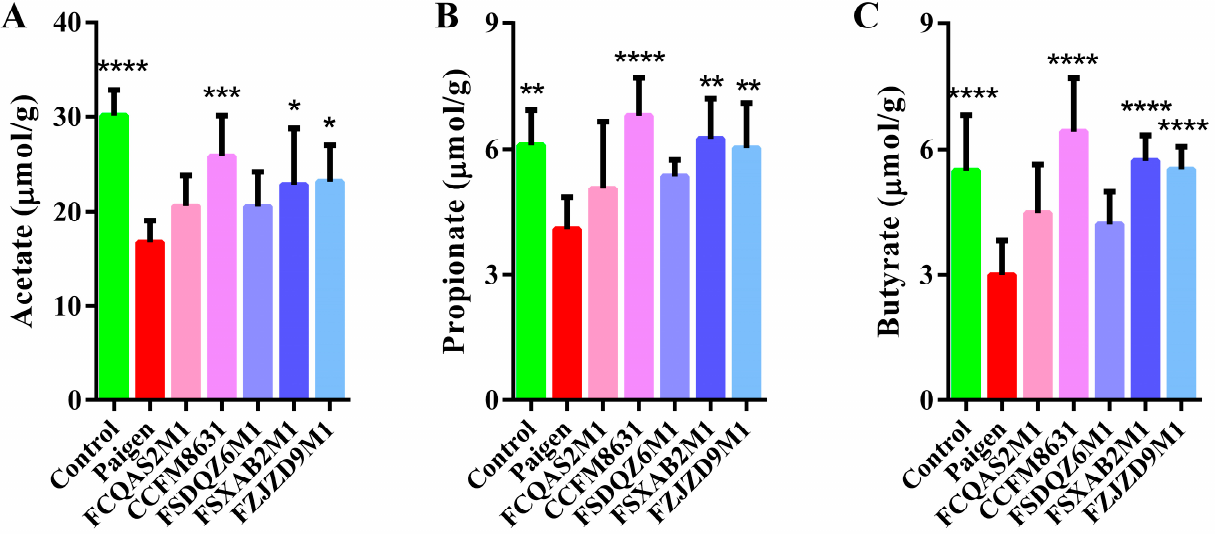
Figure 4. Lactobacillus and Bifidobacterium could improve the composition of faecal short-chain fatty acids to a certain extent. Levels of ( A ) acetate, ( B ) propionate, ( C ) butyrate. n = 8. Compared with Paigen group, * p < 0.05, ** p < 0.01, *** p < 0.001, **** p < 0.0001.